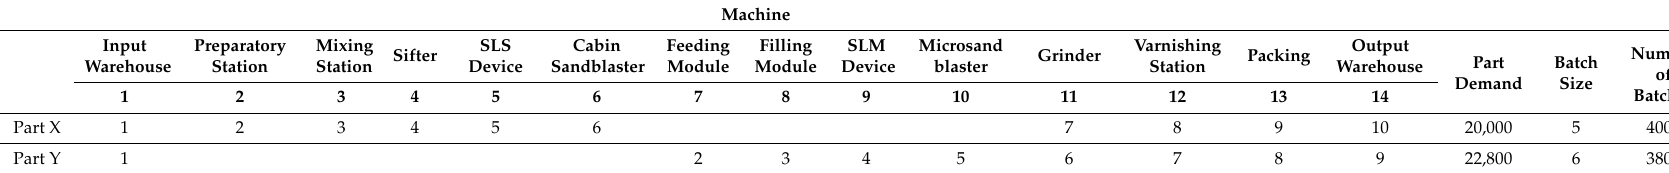
Table 3. Part flow information